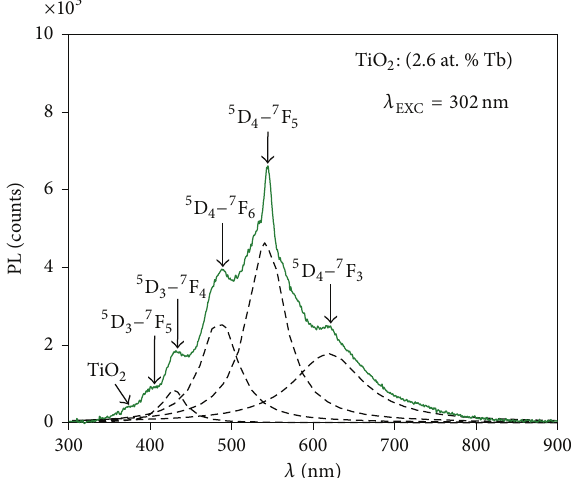
Figure 4: TiO 2 :Tb thin film photoluminescence spectrum under the excitation of Ar laser.